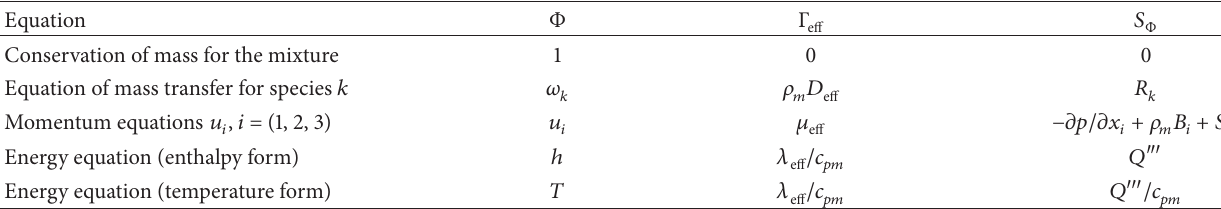
Table 3: Generalized representation of transport